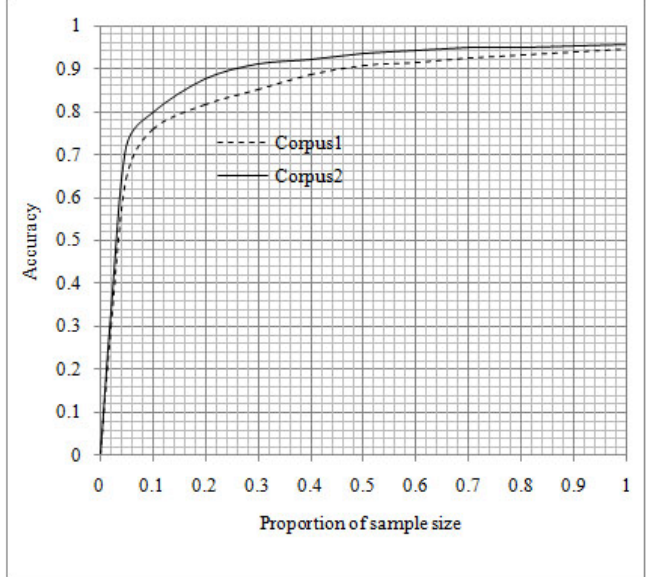
Figure 4. Accuracy and sample size proportions in corpus 1 and corpus